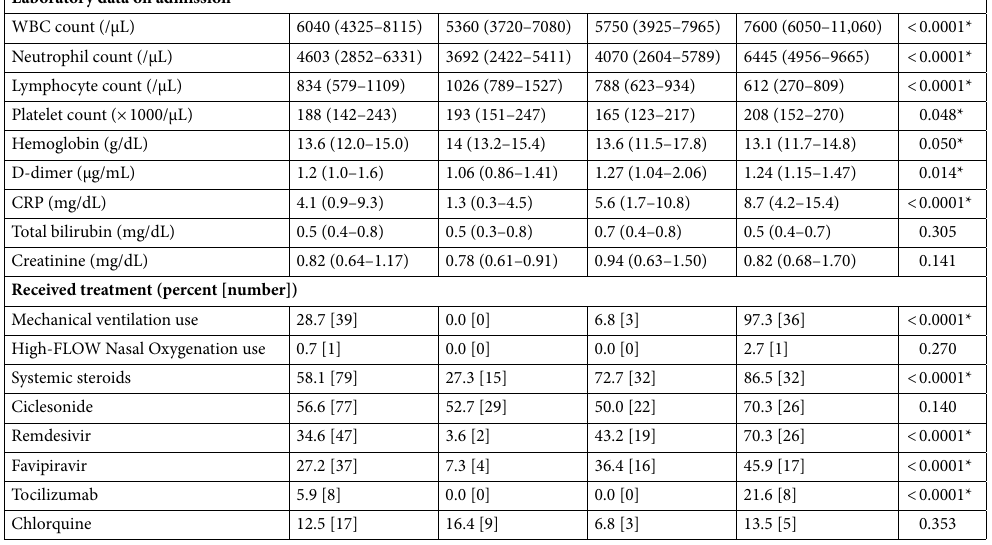
Table 2. Laboratory data on admission and treatments during hospitalization. *p <